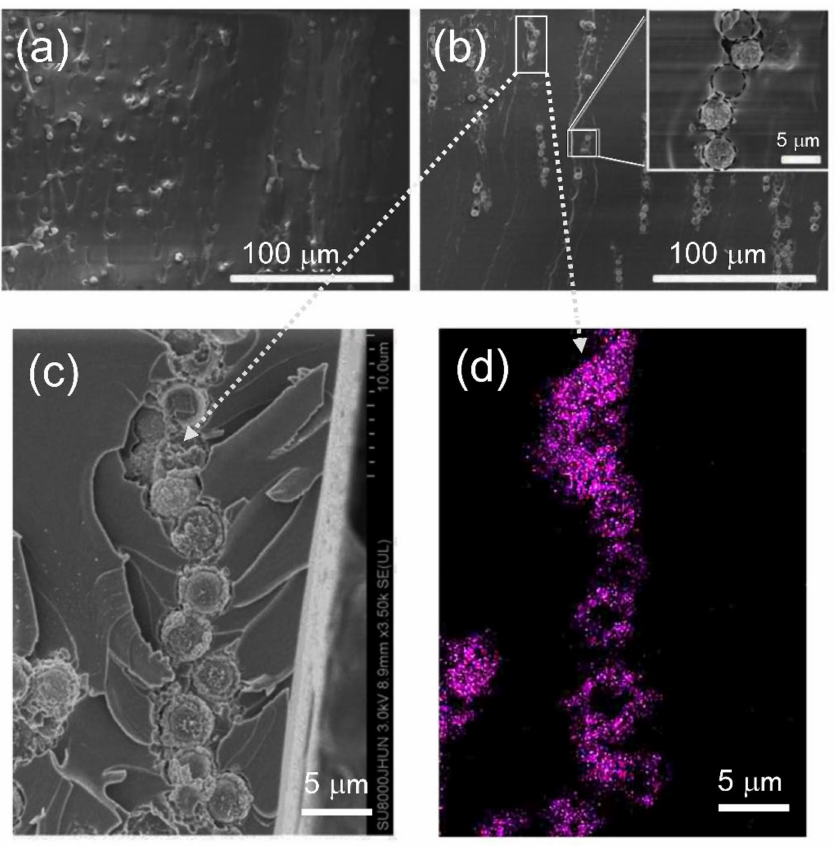
Figure 7. Cross-sectional SEM morphology of 3 wt.% Ni@PS/EP composites ( a ) unaligned, ( b , c ) aligned under 300 V/mm electric field strength, ( d ) EDS mapping of Ni corresponding to the graph.